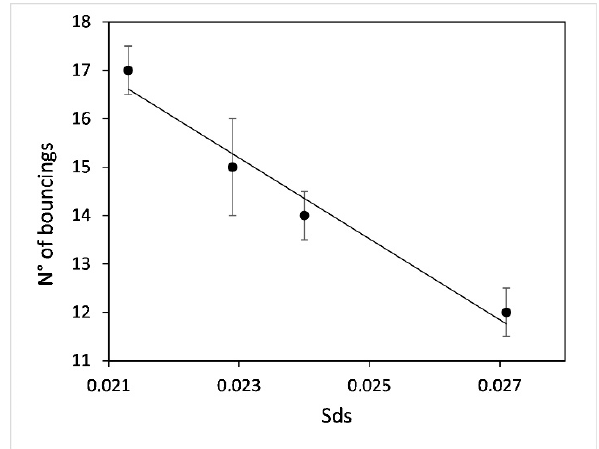
Figure 6. Number of bounces on SH surfaces as a function of the surface parameter, Sds. (The black line is a trend line).